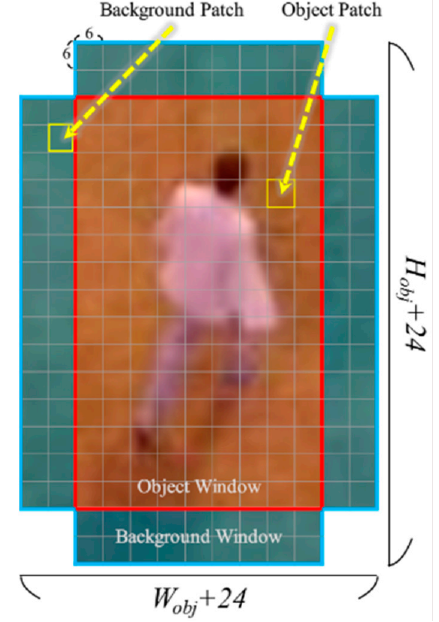
Figure 3. Object patches